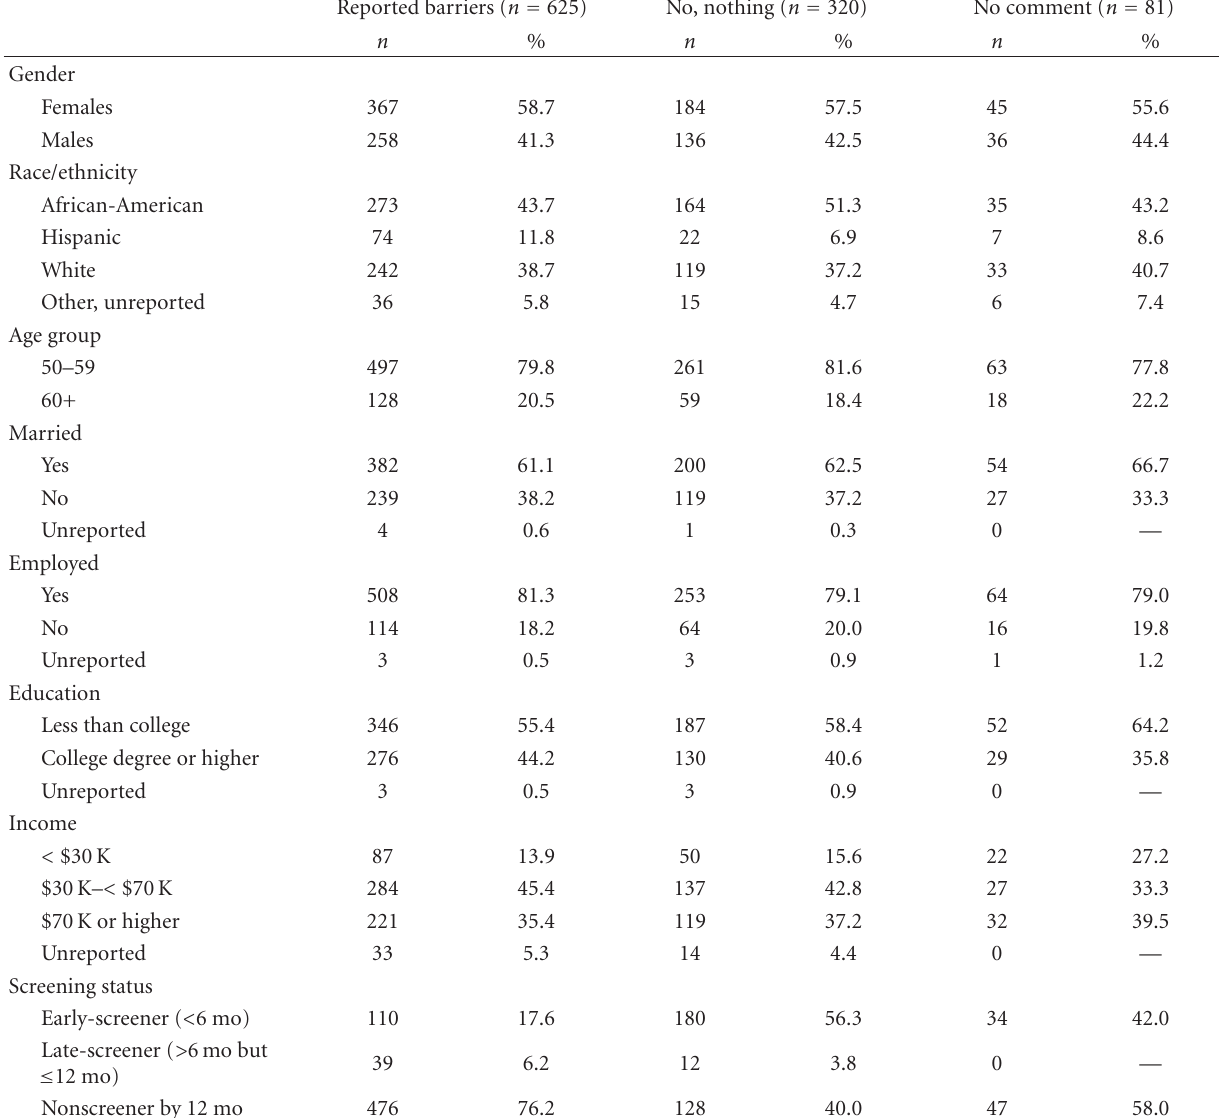
Table 1: Socio-demographic characteristics of survey respondents ( N = 1026) reporting barriers ( N = 625), “no” or “nothing” ( N = 320), or no comment ( N = 81) on the 6-month followup